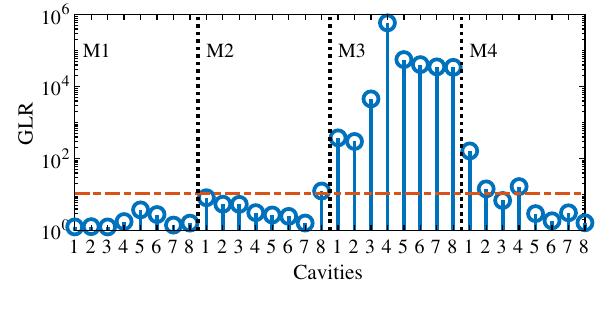
FIG. 9. Maximum GLR signal over the pulse as in Figs. 7 and 8 of all 32 cavities for the plasma discharge event observed on ¯ λ 10 . 8 is marked in red, dashed- C4.M3. The threshold of GLR ¼